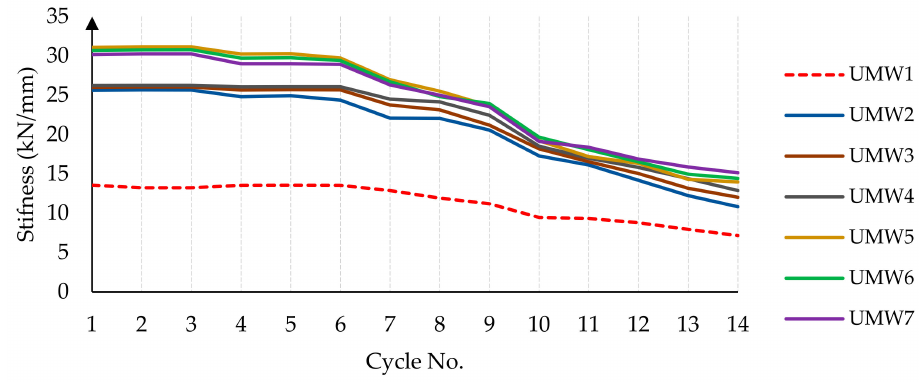
Figure 16. The stiffness reduction in masonry walls during the loading.